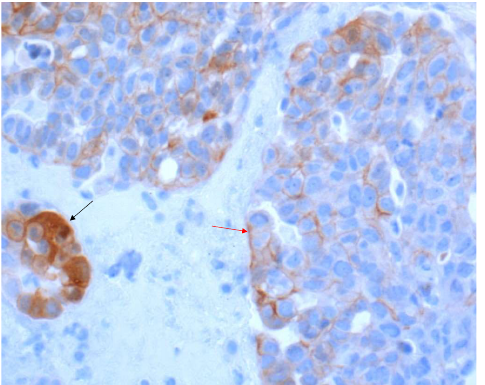
Figure 2. NSCLC with a heterogeneous PD-L1 expression pattern (40 × Obj.) In some tumor cell areas, the membranous staining is incomplete (red arrow). A tumor cell nest with cytoplasmic staining to be excluded from scoring (black